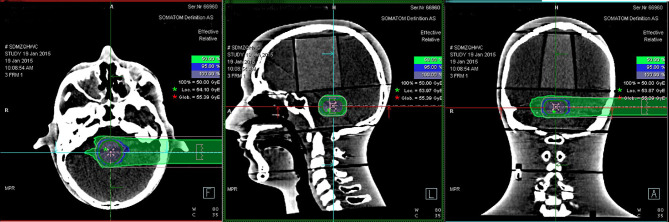
Example of rigid registration fusion for planned CT and PET/CT image.